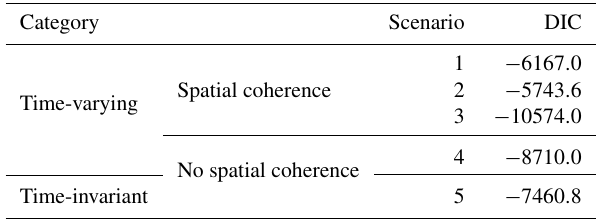
Table 5. Comparison of five scenarios in terms of the deviance in- formation criterion (DIC) when model parameters were calibrated in the dry years and verified in the wet